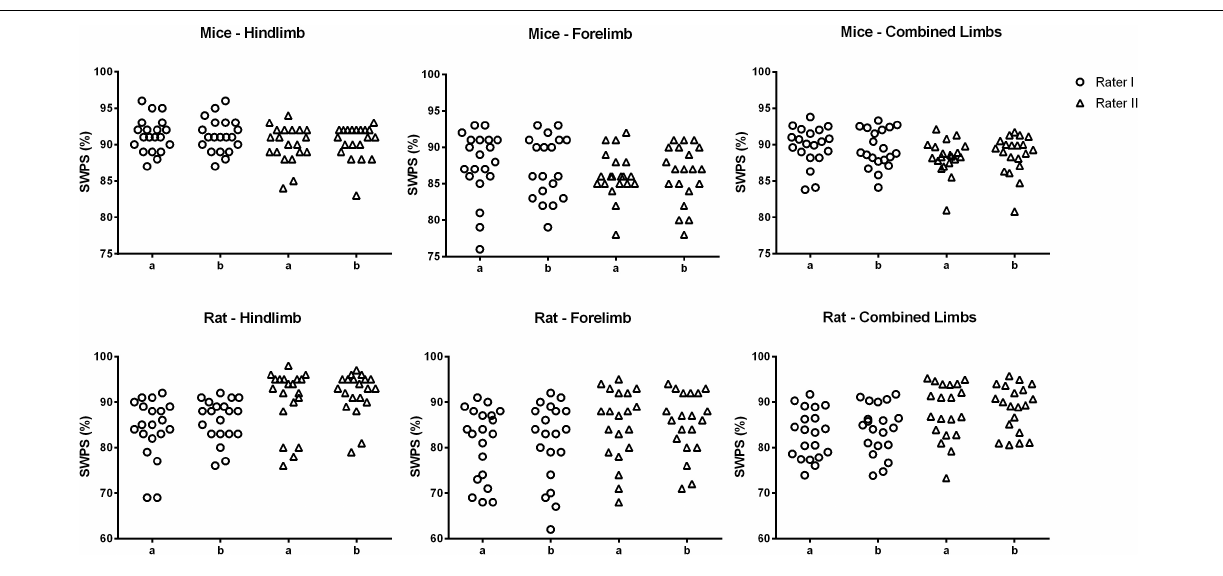
FIGURE 3 | Skilled walking performance score (SWPS) obtained at first (a) and second (b) assessment by raters I and II. Note that both assessments present the same data distribution